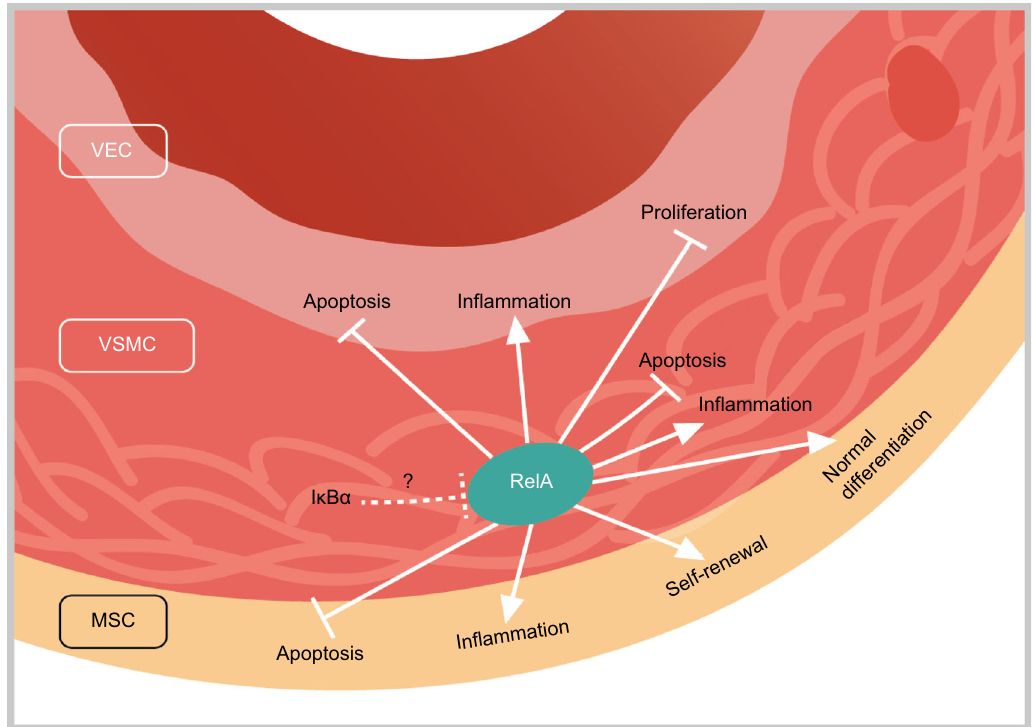
Figure 11. A proposed model showing a guardian role of RelA in maintaining human vascular cell homeostasis. (A) Under basal condition, NF- κ B/RelA inhibits the proliferation of vascular endothelial cells (VECs) and promotes the self-renewal of mesenchymal stem cells (MSCs) that are the crucial cell type of the adventitia layer. NF- κ B/RelA also maintains the multi- differentiation potentials of MSCs. Upon TNF α treatment, RelA mediates vascular in fl ammation and protects vascular cells from apoptosis. This model suggests a guardian role of RelA in maintaining human blood vessel homeostasis. Notably, I κ B α appears to modulate vascular gene expression predominantly in a RelA-independent manner under basal and in fl ammatory